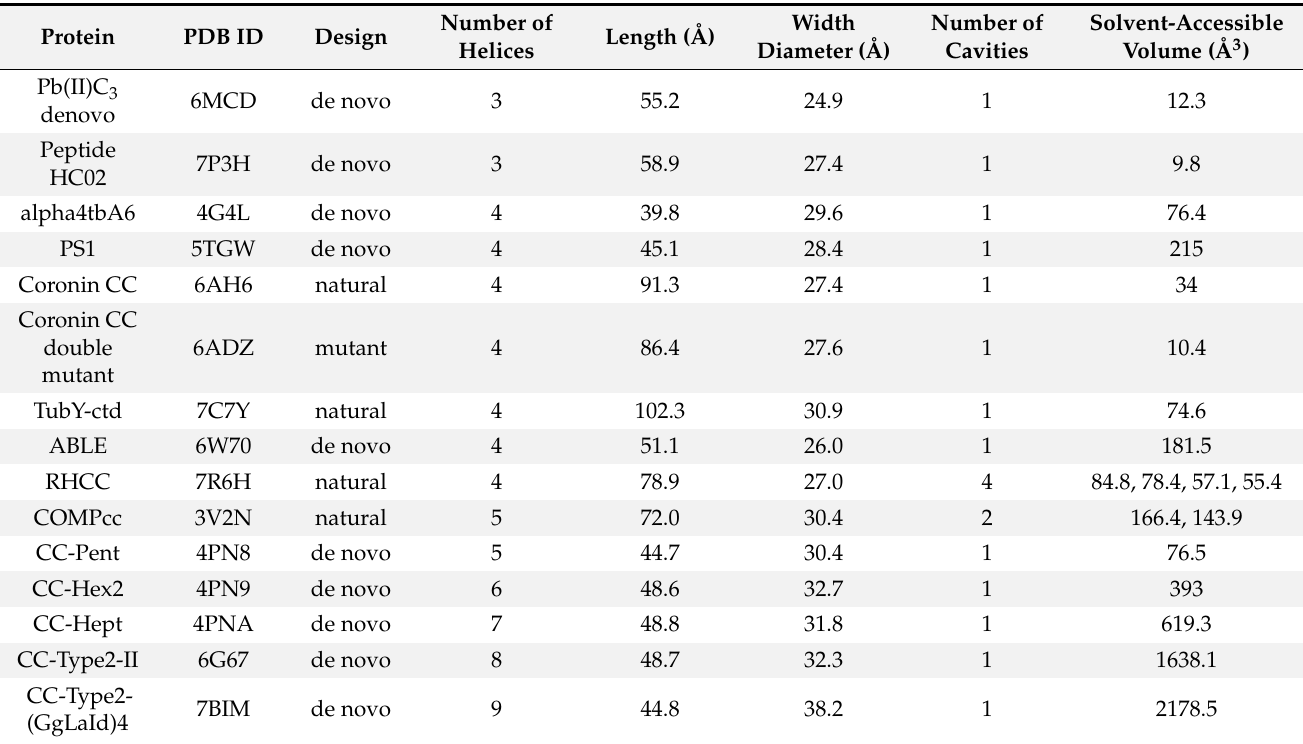
Table 1. Physicochemical properties of selected protein nanotube structures and their